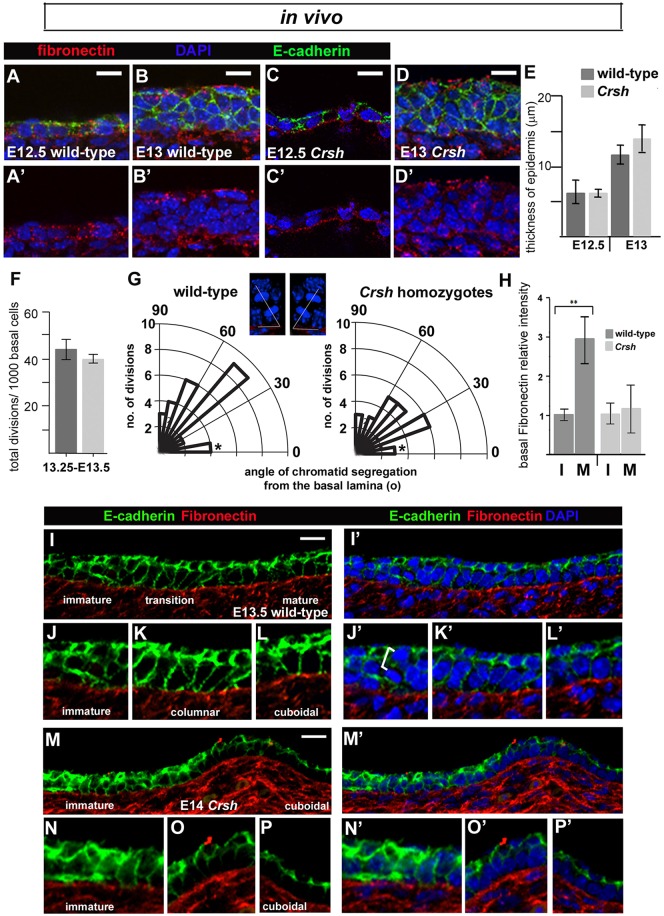
Progenitor layer formation in Crsh is associated with aberrant ECM deposition. (A–D′) Immunostaining of transverse flank epidermis, frozen sections. Scale bars: 10 µm. Representative examples of epidermal thickening and multi-cell layered epithelium formation in wild-type (A–B′) and Crsh (C–D′) littermates. (E) Quantification of epithelial thickness in two Crsh litters staged at E12.5 and two staged at E13 (four wild-type and four Crsh homozygote embryos). Results are mean±s.d. (F) Frequency of cell division within the immature epidermis. Results are mean±s.d. Three wild-type and three Crsh embryos from two litters were analysed. (G) Polar plots of telophase divisions in E13.25–E13.5 wild-type (n=25) and Crsh (n=25) epidermis were scored and the mean angle of their oriented cell division was measured relative to the basal lamina (x-axis). Asterisks highlight the cell divisions in the 0–15° binned group, which were planar and occurred only within the superficial layer. Insets are representative examples of the methodology used to measure the mean angle of cell division relative to the basal lamina (see Materials and Methods). White lines denote angles of cell division measured. Three wild-type and three Crsh embryos from two litters were analysed. (H) Relative fibronectin staining pixel intensities at the basal lamina of the immature (I) normalised to the mature (M) epithelium in wild-type (n=3) and Crsh littermates (n=4). Results are mean±s.d. **P<0.014 (t-test). (I–P′) Fibronectin and E-cadherin immunostaining of longitudinal flank epidermis, frozen sections. The E-cadherin channel (green) has been digitally brightened to show cell outlines. Scale bars: 10 µm. Representative examples of progenitor monolayer formation in wild-type (I–L′) and Crsh (M–P′) littermates. J–L′ and N–P′ show enlargements of images from I,I′ and M,M′ highlighting the progression in progenitor monolayer formation.